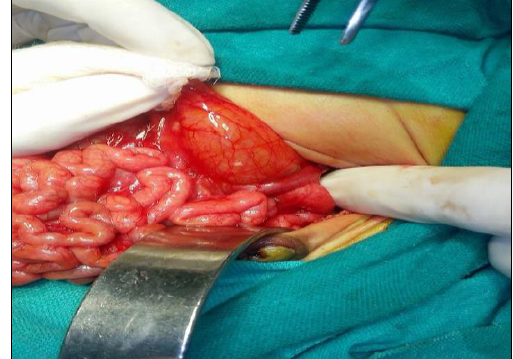
Figure 4: Case 3- PDPV crossing duodenum